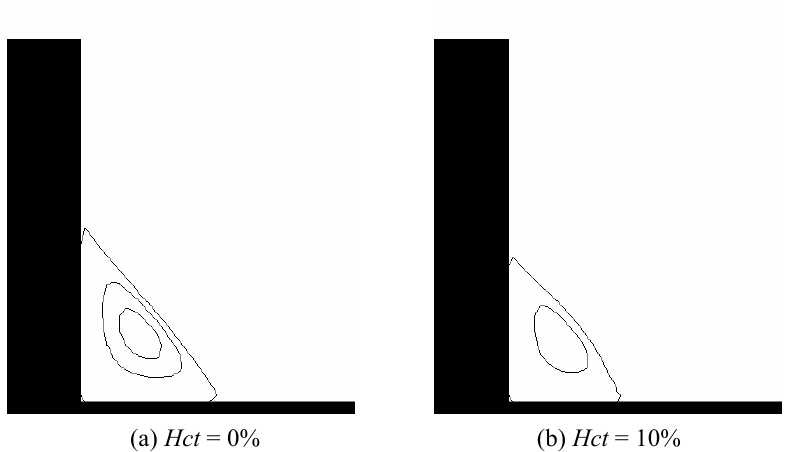
Fig.7 Stream lines in a separated region with Hct = 0 and 10% ( Re = 1)